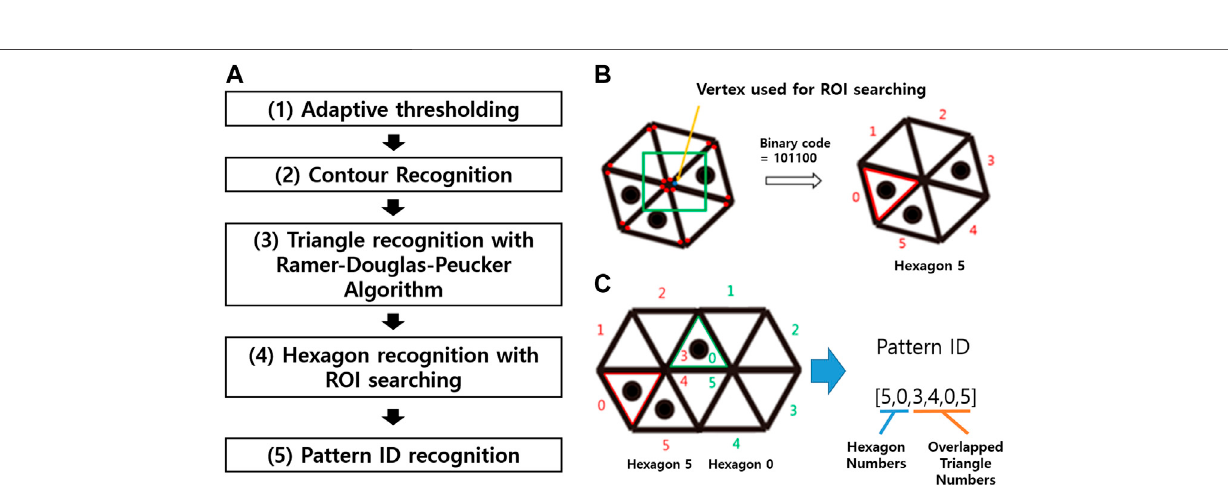
FIGURE4|(A) Flowchartsummarizingthestepstopatternrecognition.(1)BinarizetheoriginalRGBimagesusinganadaptivethresholdingmethod.(2)Recognize theboundariesofbinarizedimagestoobtainthecontours.(3)UsetheRamer – Douglas – Peuckeralgorithmtoidentifythetrianglesandvertexlocationsfromthecontours. (4)Identifythehexagonalpatternsbydecodingthebinarycode.(5)RecognizethepatternIDbydeterminingwhichandhowtheneighboringhexagonsareintegrated. (B) Individual hexagonal pattern identi fi cation process. Using the square ROI centered about the triangle vertices found in Step 3, when six vertices are included in the ROI, the binary code for the triangles is read clockwise, beginning with the vertex corresponding to the ROI center. The binary code is used to recognize the hexagonal patterns and each corresponding triangle, because the hexagonal patterns are not radially symmetric. (C) Integrated hexagonal pattern identi fi cation process. The fi nal pattern ID can be recognized by identifying the overlapping triangles. Here, Triangles 3 and 4 of Hexagon 5 are overlapping with 0 and 5 of Hexagon